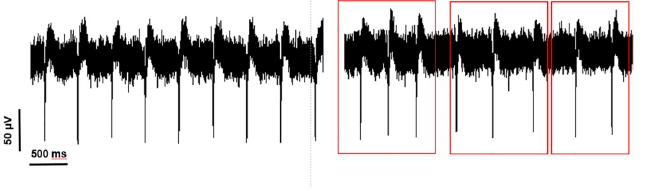
Fig 10. The variable pattern of electrical fluctuations. Red squares show areas with variable patterns.